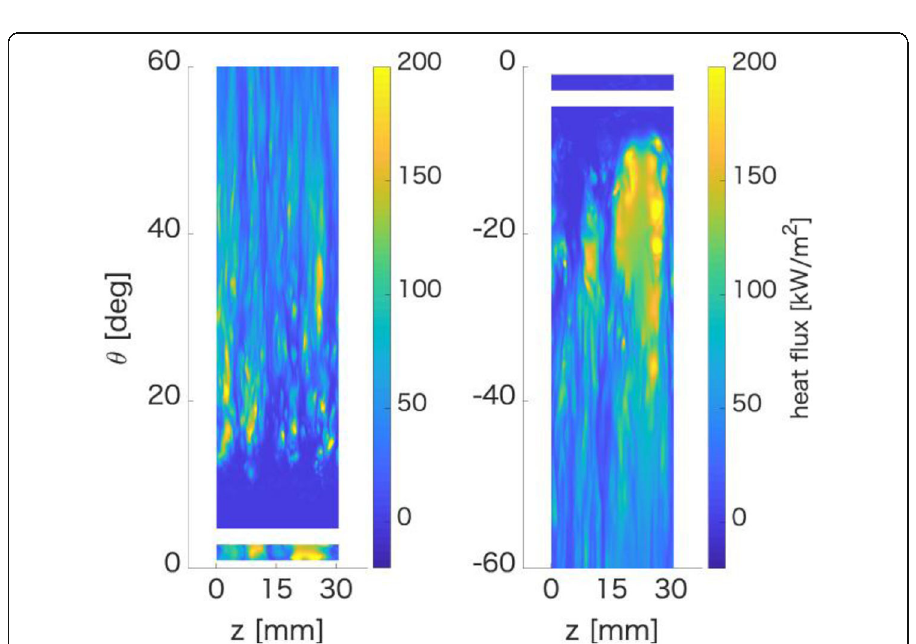
Fig. 5 A snapshot of heat flux distribution (Point